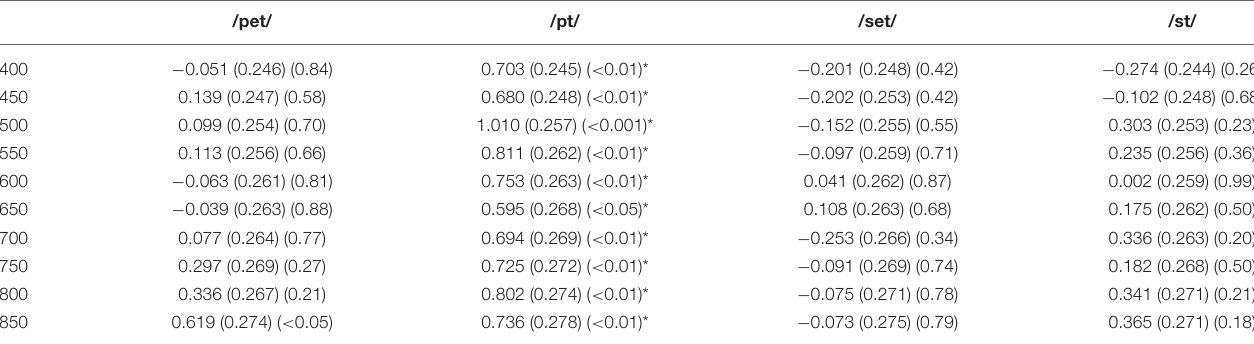
TABLE 3 | The significant interactions between attention and language experience (MEM random slope analysis) in response to only the /pt/ onset that occurs in the Polish language, but not the English language, between 400 and